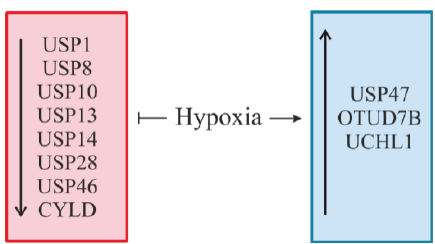
Figure 8. Regulation of DUBs by hypoxia. Hypoxia can cause either a decrease in the level of certain DUBs (depicted in red) or an increase in the level of other DUBs (depicted in blue).